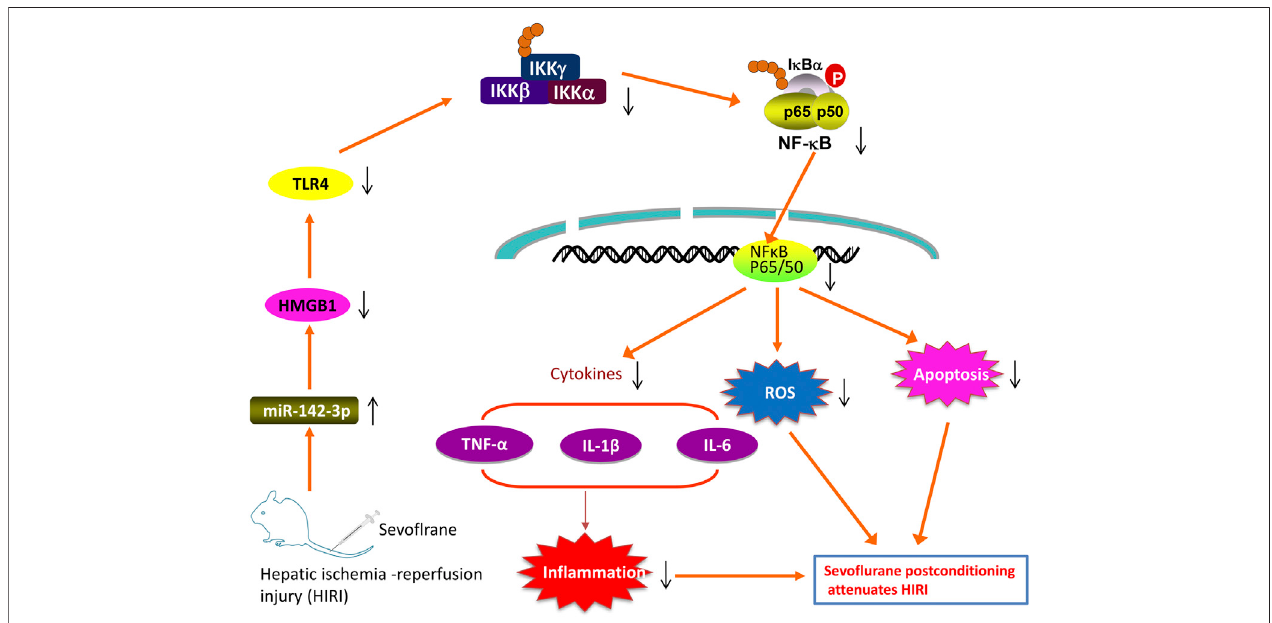
FIGURE 9 | Schematic diagrams showing that Sevo postconditioning counteracts the downregulation of miR-142 provoked by I/R, in turn decreased the expressionofHMGB1,blockingTLR4/NF- κ Bpathwayactivation,thusimprovinghepaticI/Rinjury,asevidencedbythesuppressionofin fl ammatoryresponses,oxidant stress and cell